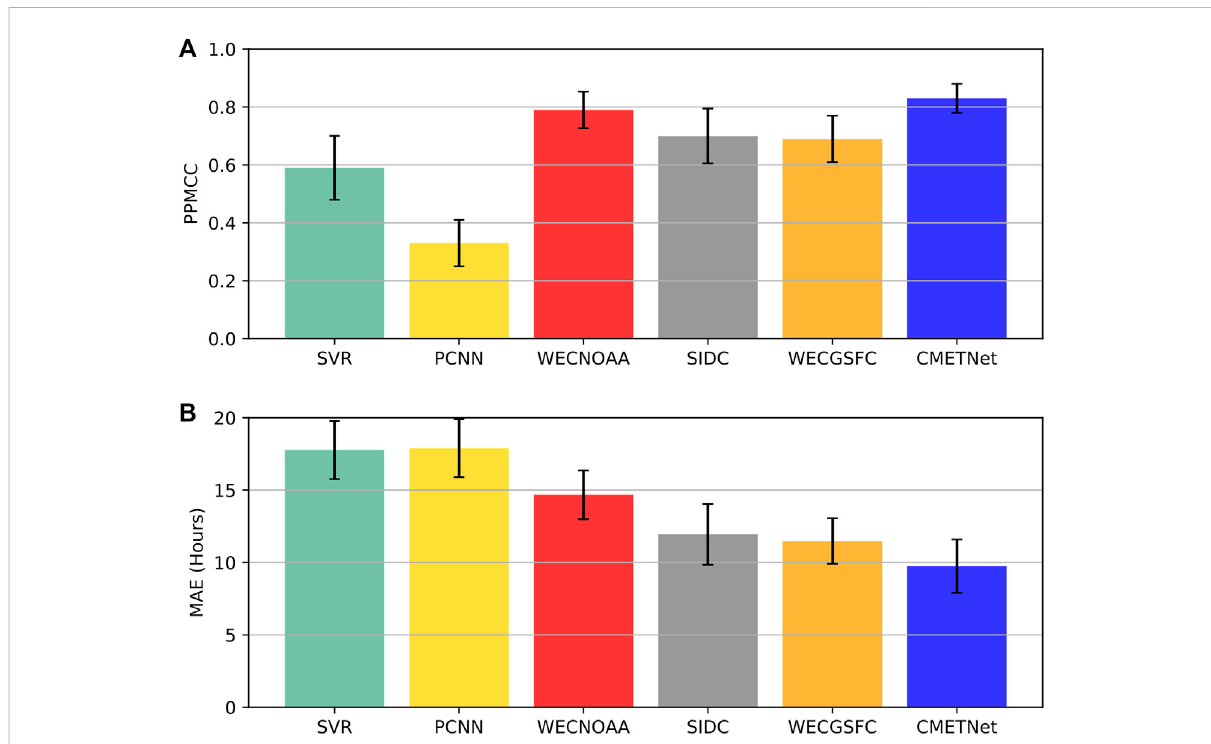
FIGURE 8 Performancecomparisonof six methods for CME arrival time prediction. CMETNet istheensemble learningframeworkproposed inthispaper. SVR and PCNN are previously published machine learning methods. WECNOAA, SIDC, and WECGSFC are physics-based models presented on NASA ’ s CCMC CME Scoreboard. (A) Pearson product-moment correlation coef fi cients (PPMCCs) of the six methods. (B) Mean absolute errors (MAEs) of the six methods. CMETNet outperforms the other fi ve methods in terms of both PPMCC and